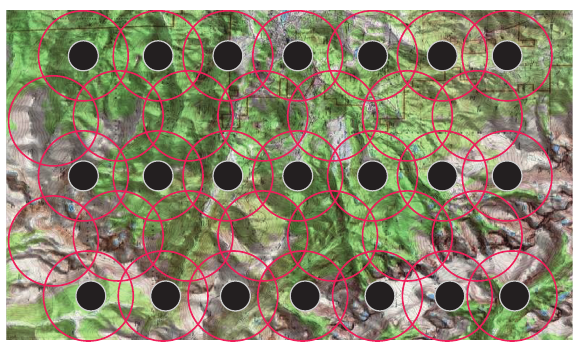
Figure 4: Schematic of the linear